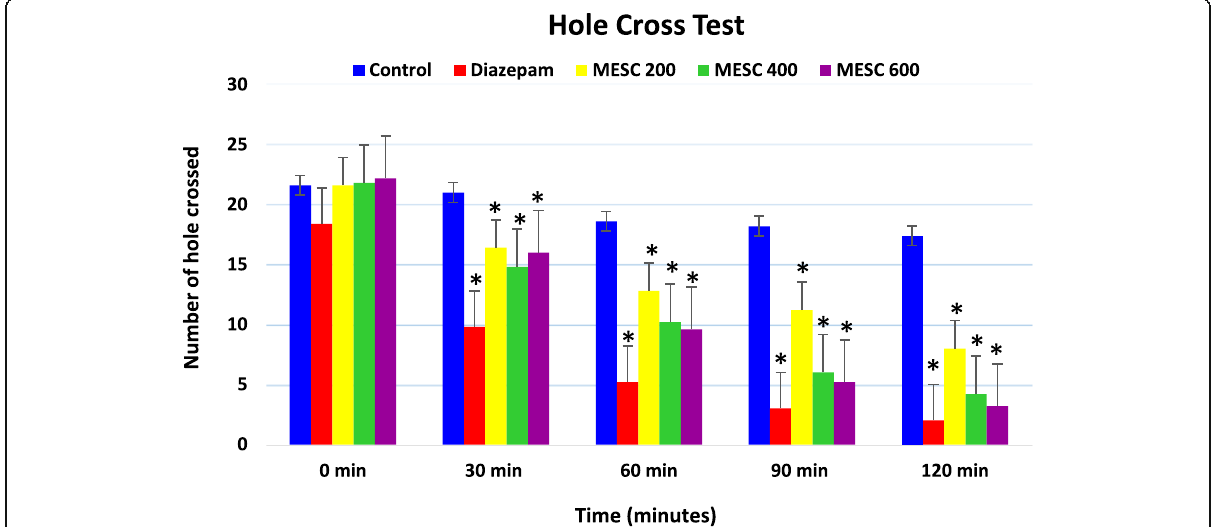
Fig. 2 The sedative effect of MESC on hole cross test in mice. i. * p < 0.001 vs control group. ii.** p < 0.0001 vs control group [Control (NaCl